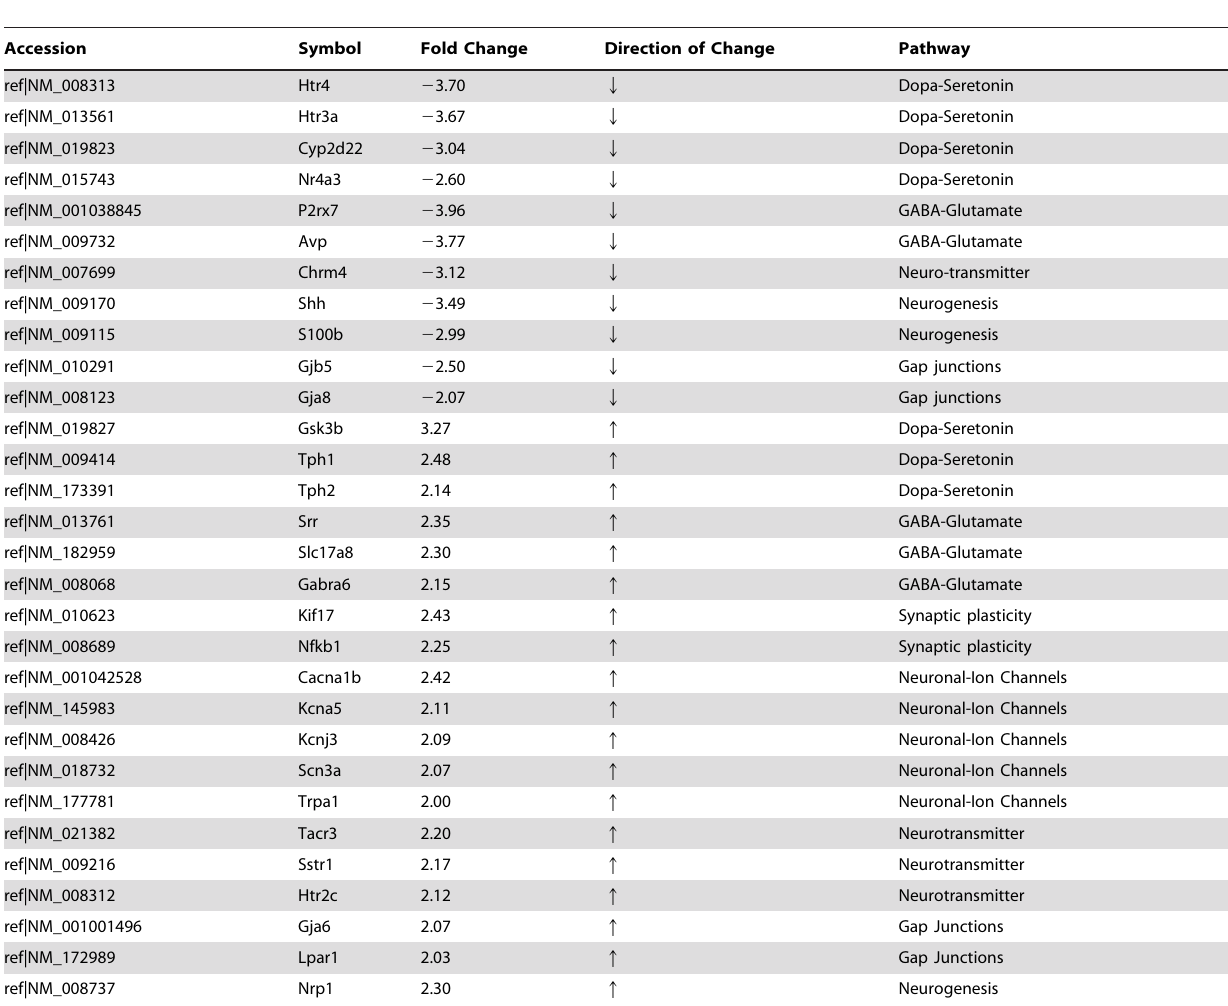
Table 1. Neural genes altered $ 2 fold in the cerebral hemisphere of male pups from mothers having FA supplementation during gestation at 4 mg/kg in comparison to mothers at 0.4 mg/kg